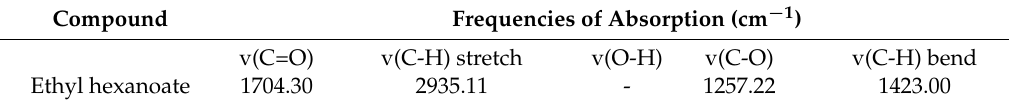
Table 1. Infrared spectrum of ethyl hexanoate.